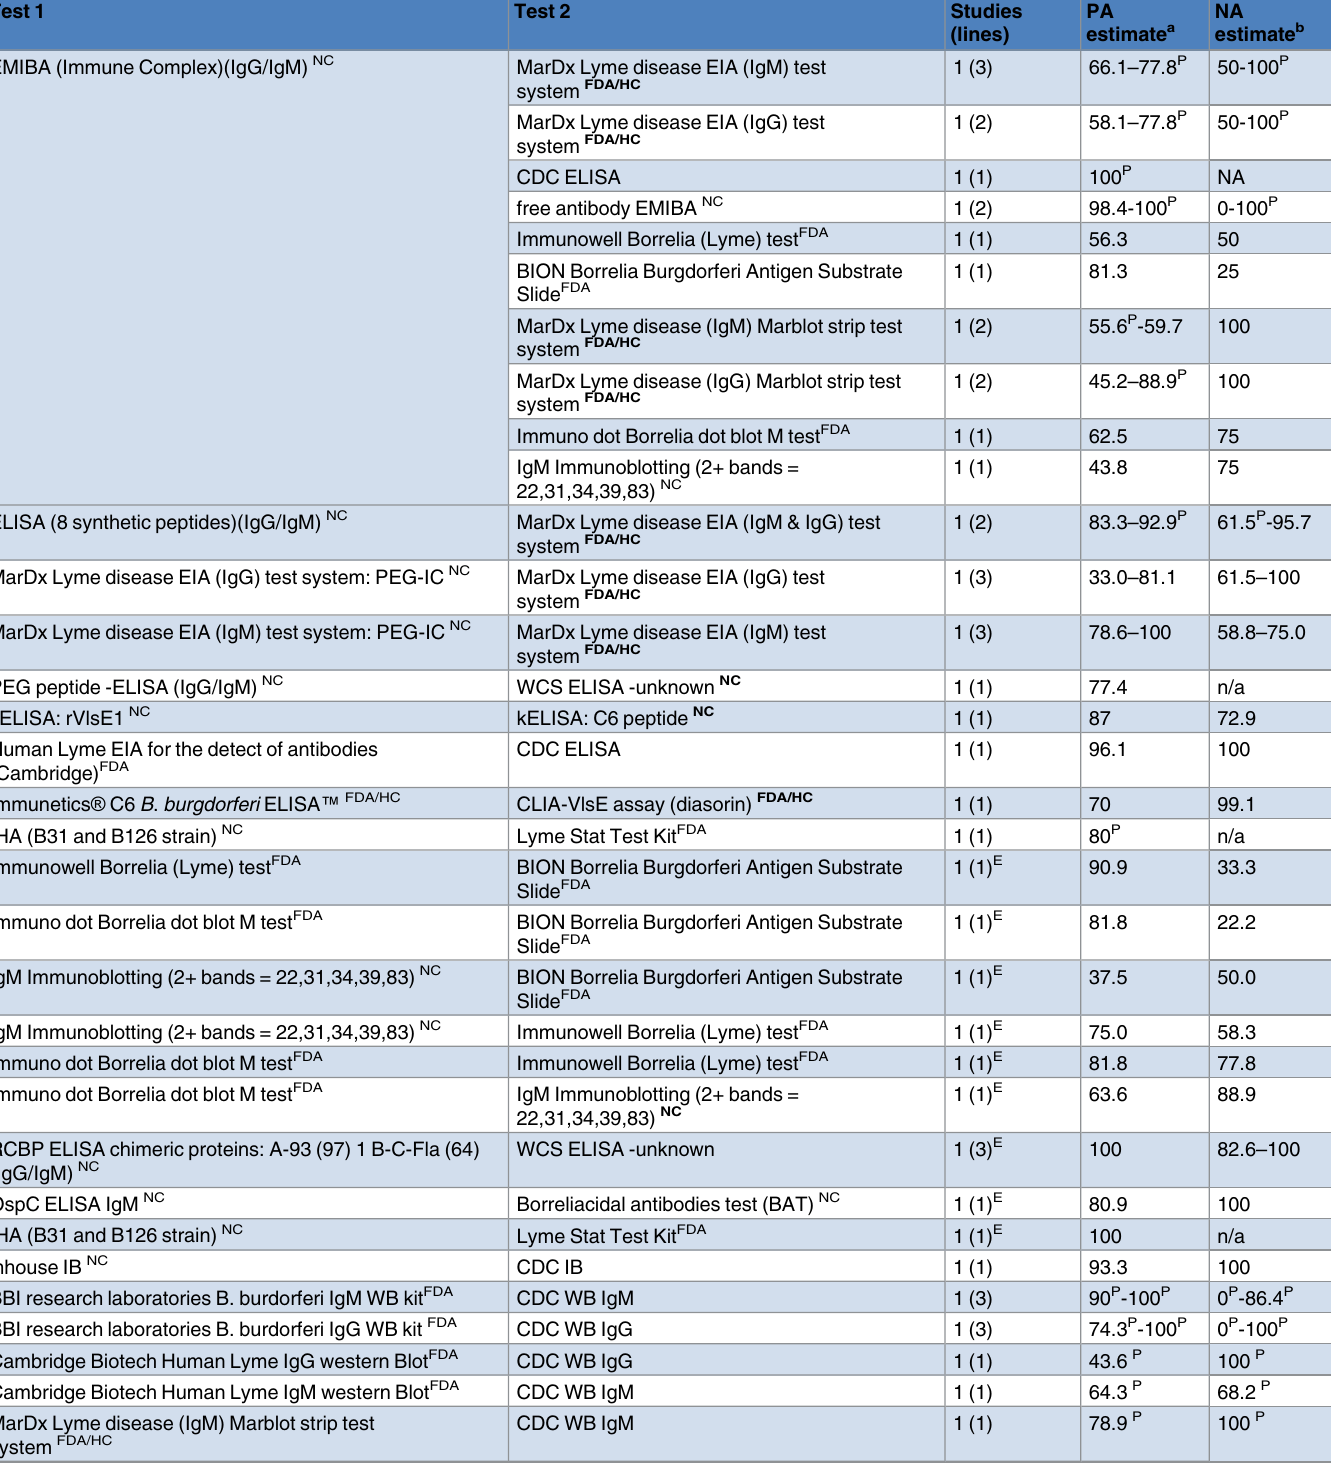
Table 6. Summaryor range of agreementreported in 14 studies (51 lines of data) evaluating different tests paired against each other and tested on samples meeting the clinical definition of Lyme disease or a test